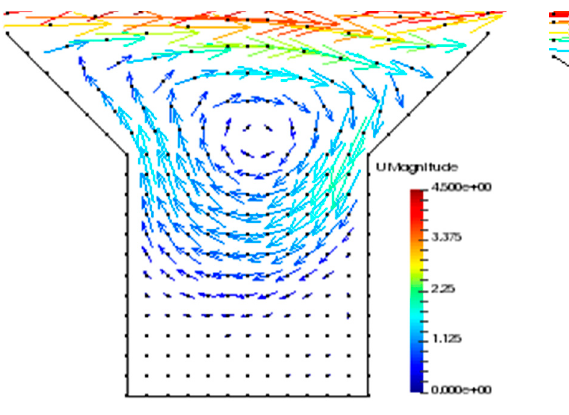
Z H /H = 0.5 Z H /H = 0.33